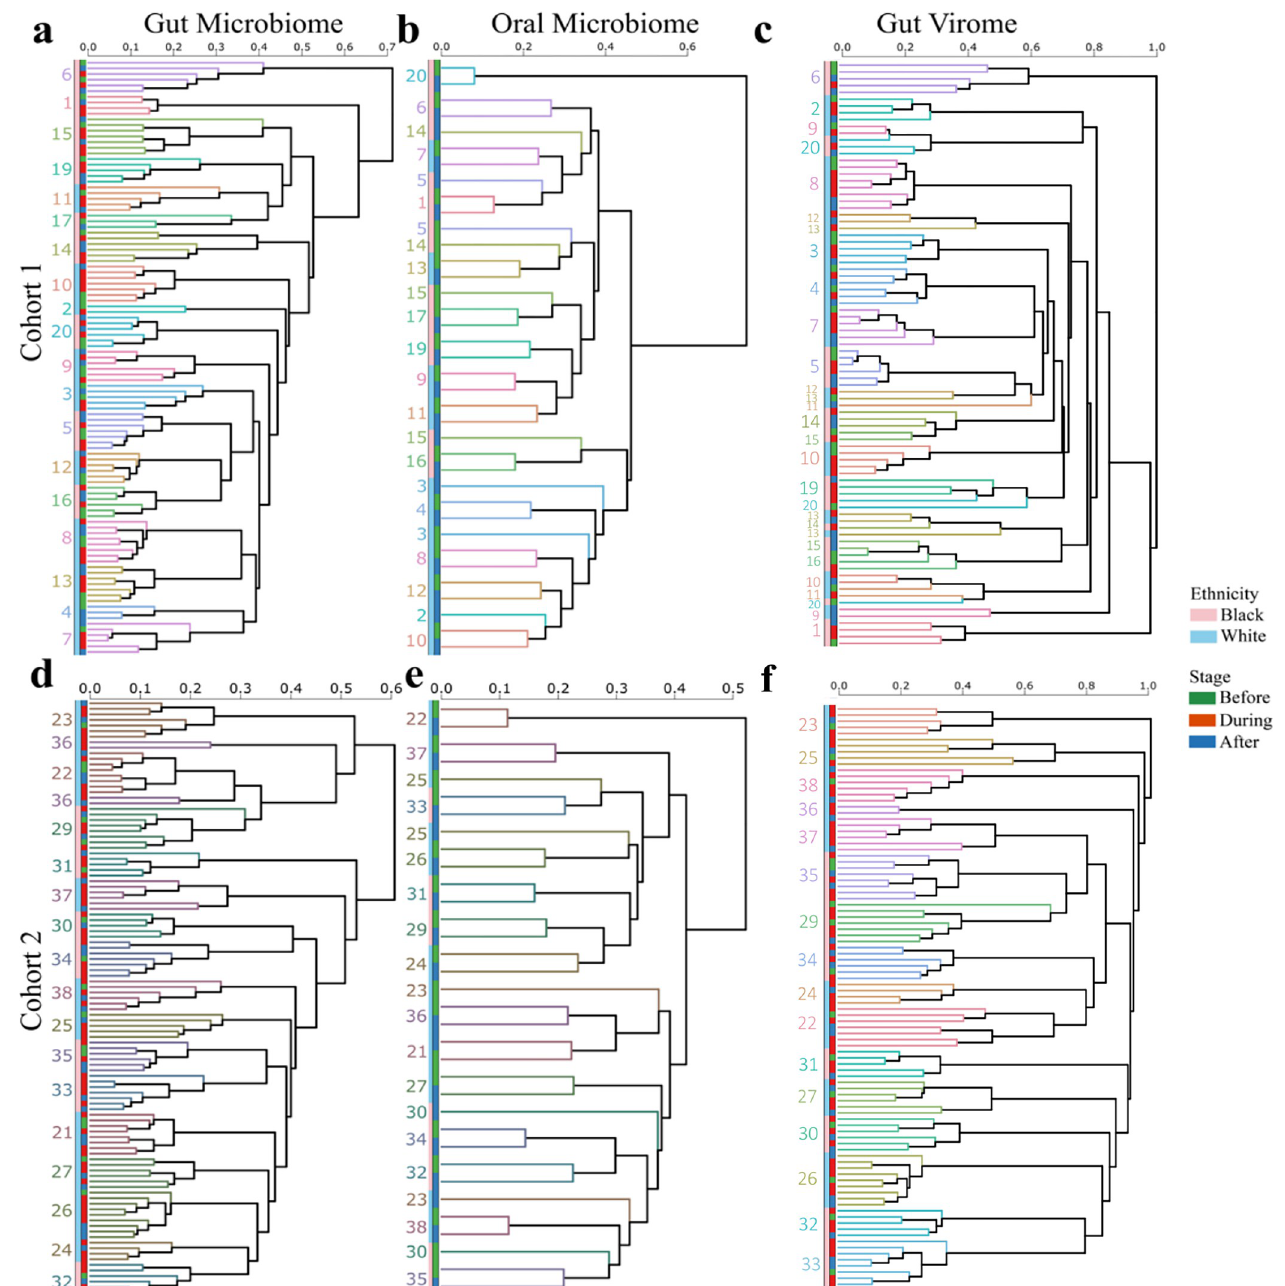
Fig 2. Dendrograms summarizing relationships of microbial community compositions before, during, and after the diet. Participants are individually colored in the branches, and ethnicities (light blue and pink) are denoted at the tips of the branches along with the before (green), during (red), and after (blue) stages of the dietary intervention. Unweighted pair group method with arithmetic mean (UPGMA) clustering trees are shown for the (A, D) gut and (B, E) oral microbial community compositions and (C, F) gut viral community composition in (A-C) cohort 1 and (D-F) cohort 2 based on Bray–Curtis distances (permutations = 999). Data underlying this figure can be found at S1